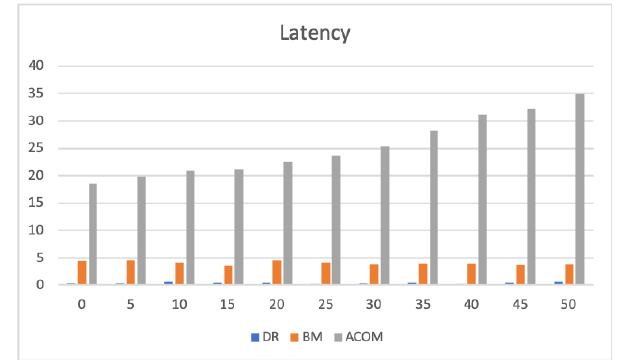
Figure 8. Latency of three mechanisms.